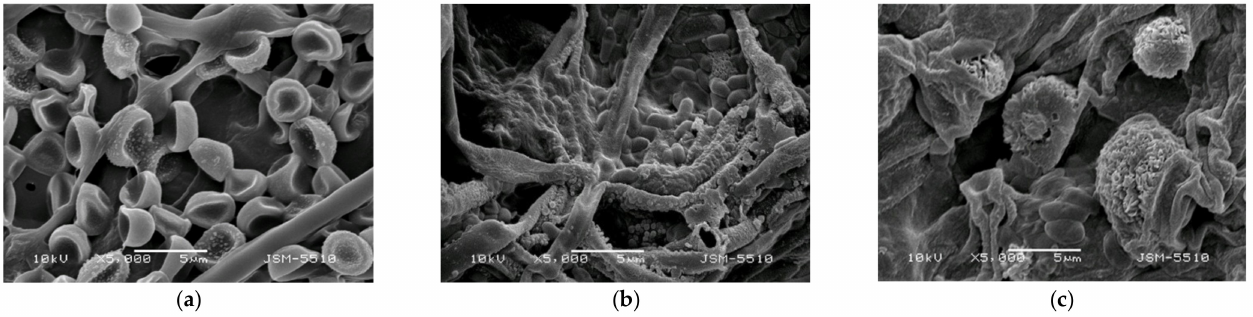
Figure 5. SEM images of the ( a ) T. asperellum spores, ( b ) P. chlamydospora conidia and ( c ) P. aleophilum